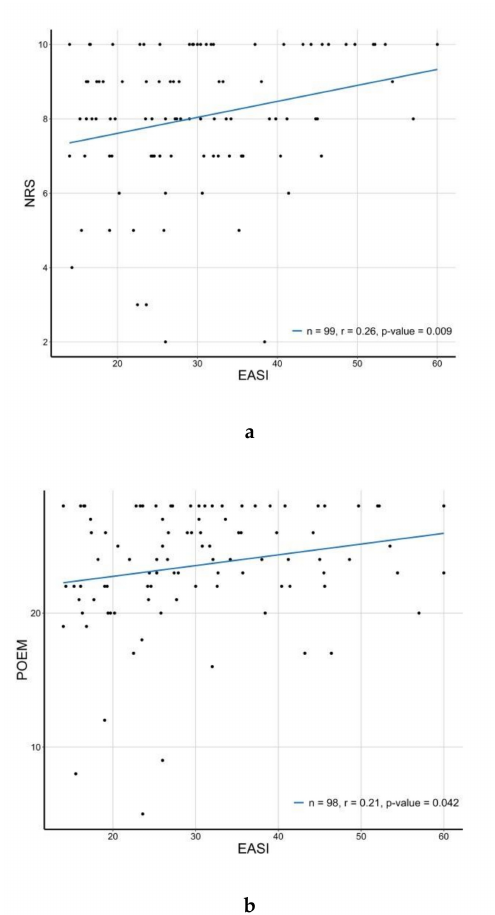
Figure 1. Correlation between ( a ) Eczema Area and Severity Index (EASI) and Numerical Rating Scale (NRS) ( R = 0.26, p = 0.009), and ( b ) EASI and Patient Oriented Eczema Measure (POEM) ( R = 0.21, p = 0.042) at